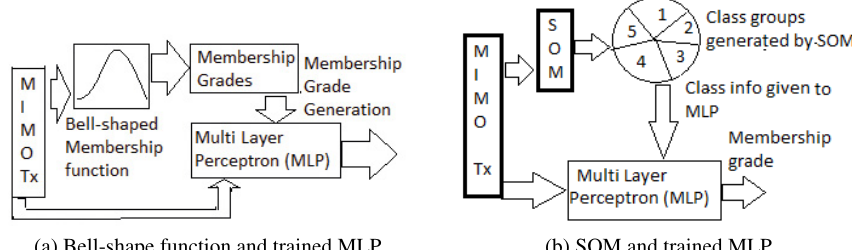
Figure 3. Membership grade generation